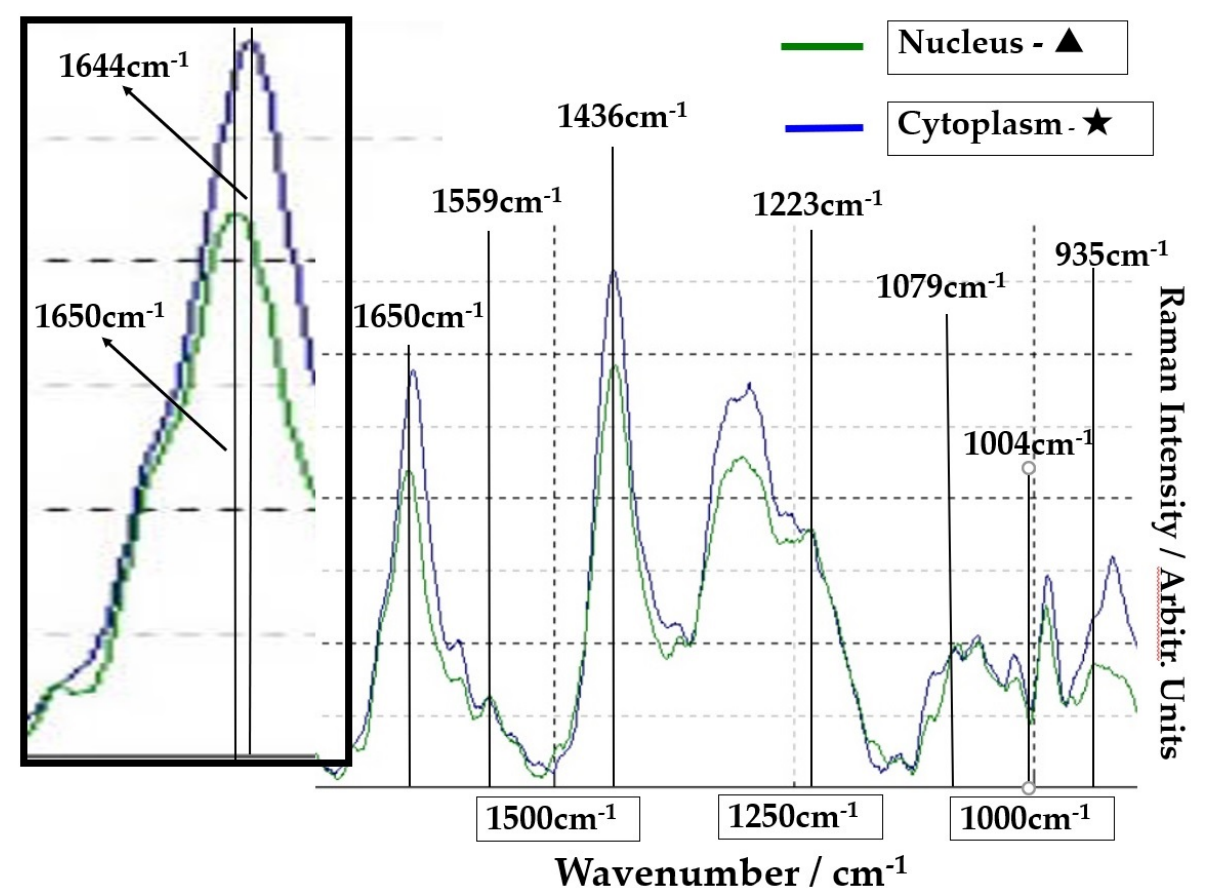
Figure 5. Comparison of spectra from nuclei (point ▲ ) of SCC cells (green line) and cytoplasm (point ★ ) (blue line). The left frame is the expansion of the peak of 1650 cm − 1 .